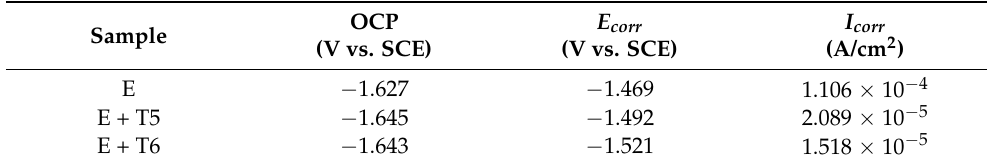
Table 2. The results of OCP, corrosion potential and corrosion current of as-extruded, T5 and T6